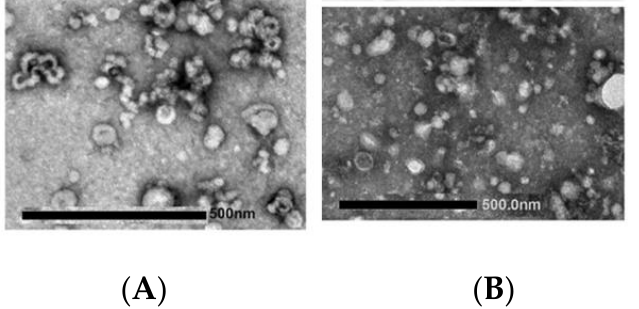
Figure 8. Transmission electron micrographs of exosome samples collected from cell culture and visualized after negative staining. In ( A ) the preparation is a population of large and small vesicles; the morphology is not uniform, some vesicles appear with a cup-like structure some with a deformed shape. Slight clumping can also be observed. In ( B ) vesicles are surrounded by microparticles, precipitates, and impurities generated in the stain or during preparation.